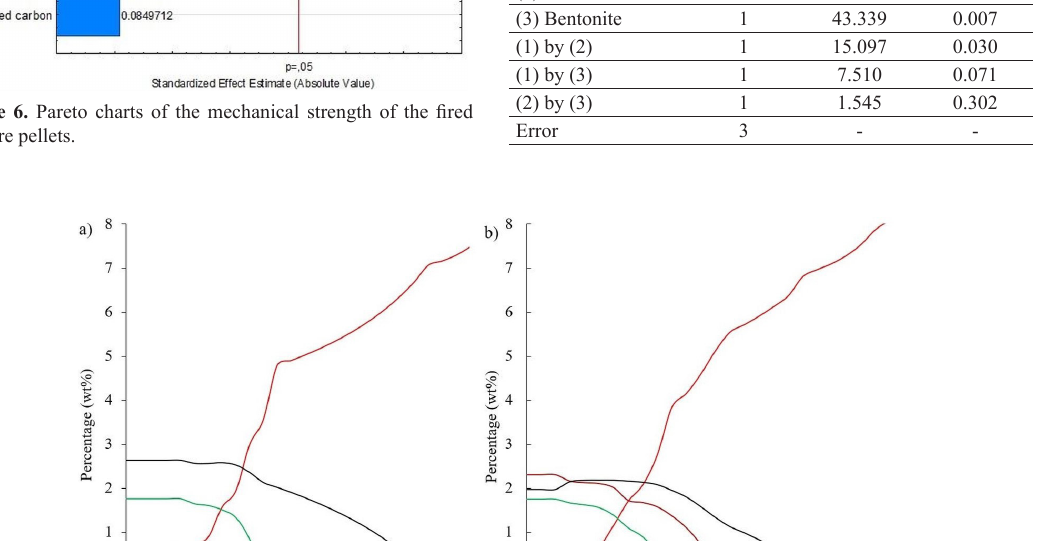
–C –B . 0.3 1.1 0.7